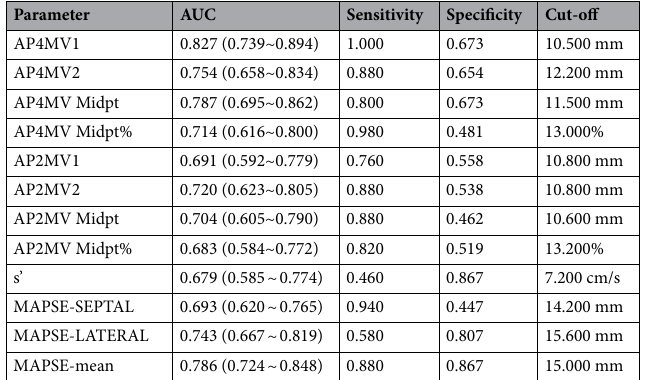
Table 7. ROC curves of TMAD parameters, MAPSE parameters and s’ predicting LV systolic dysfunction in patients with